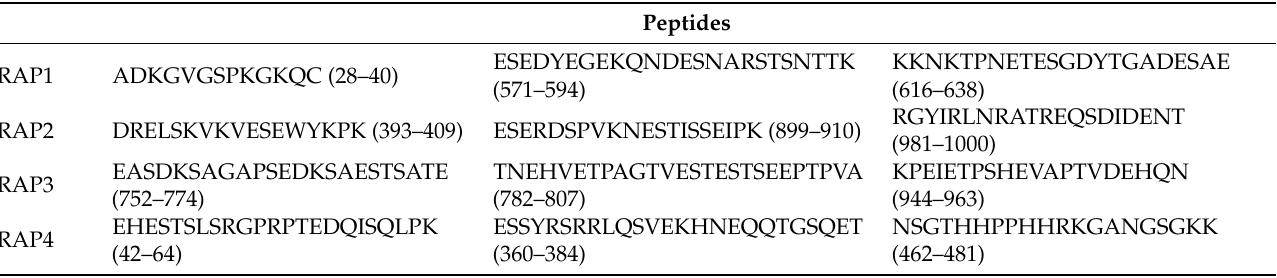
Table 2. TRAP peptides used for rabbit immunization to generate specific antibodies against B. bovis TRAP